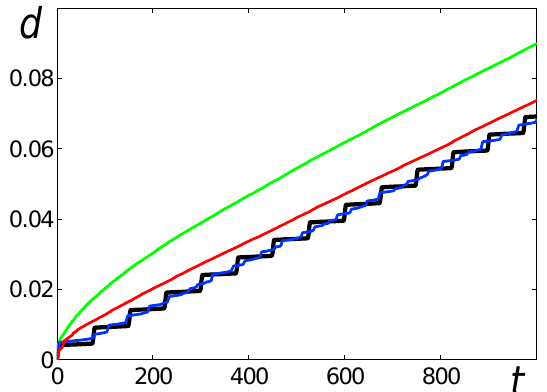
Figure 5. Stochastic cycles for ε = 10 − 6 (green), ε = 10 − 5 (blue), and ε = 5 × 10 − 5 (red): (a) random trajectories p (Pa) vs. u (ms − 1 ), (b) probability density functions of u coordinates (ms − 1 ), and (c) probability density functions of the period T (s).